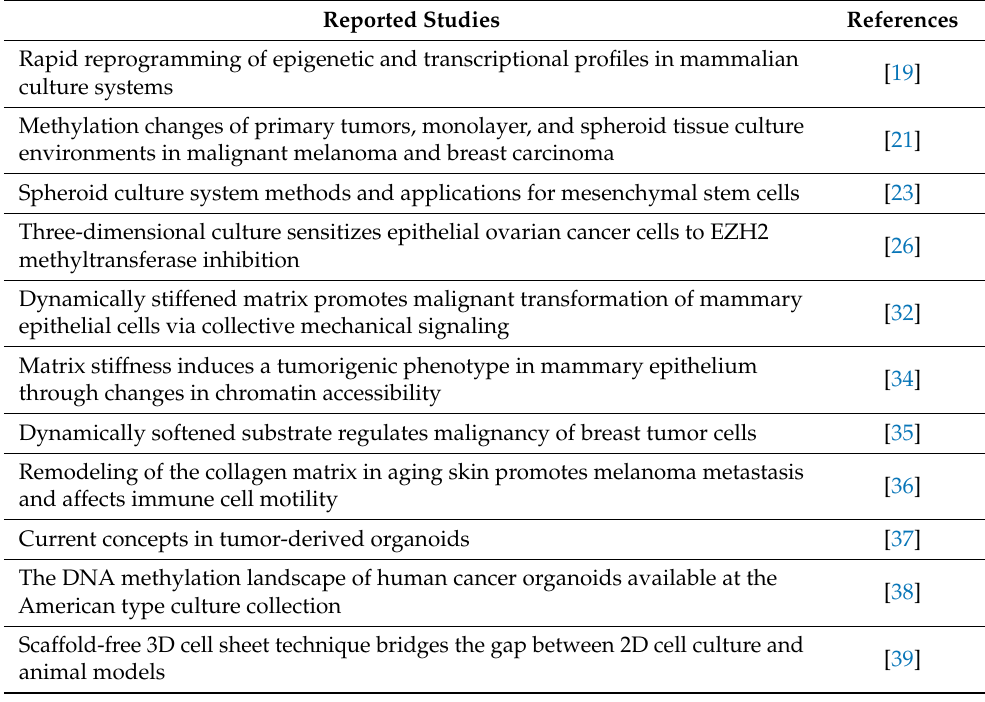
Table 3. A summary of studies examining epigenetic regulation in 3D cancer cell cultures. Reported